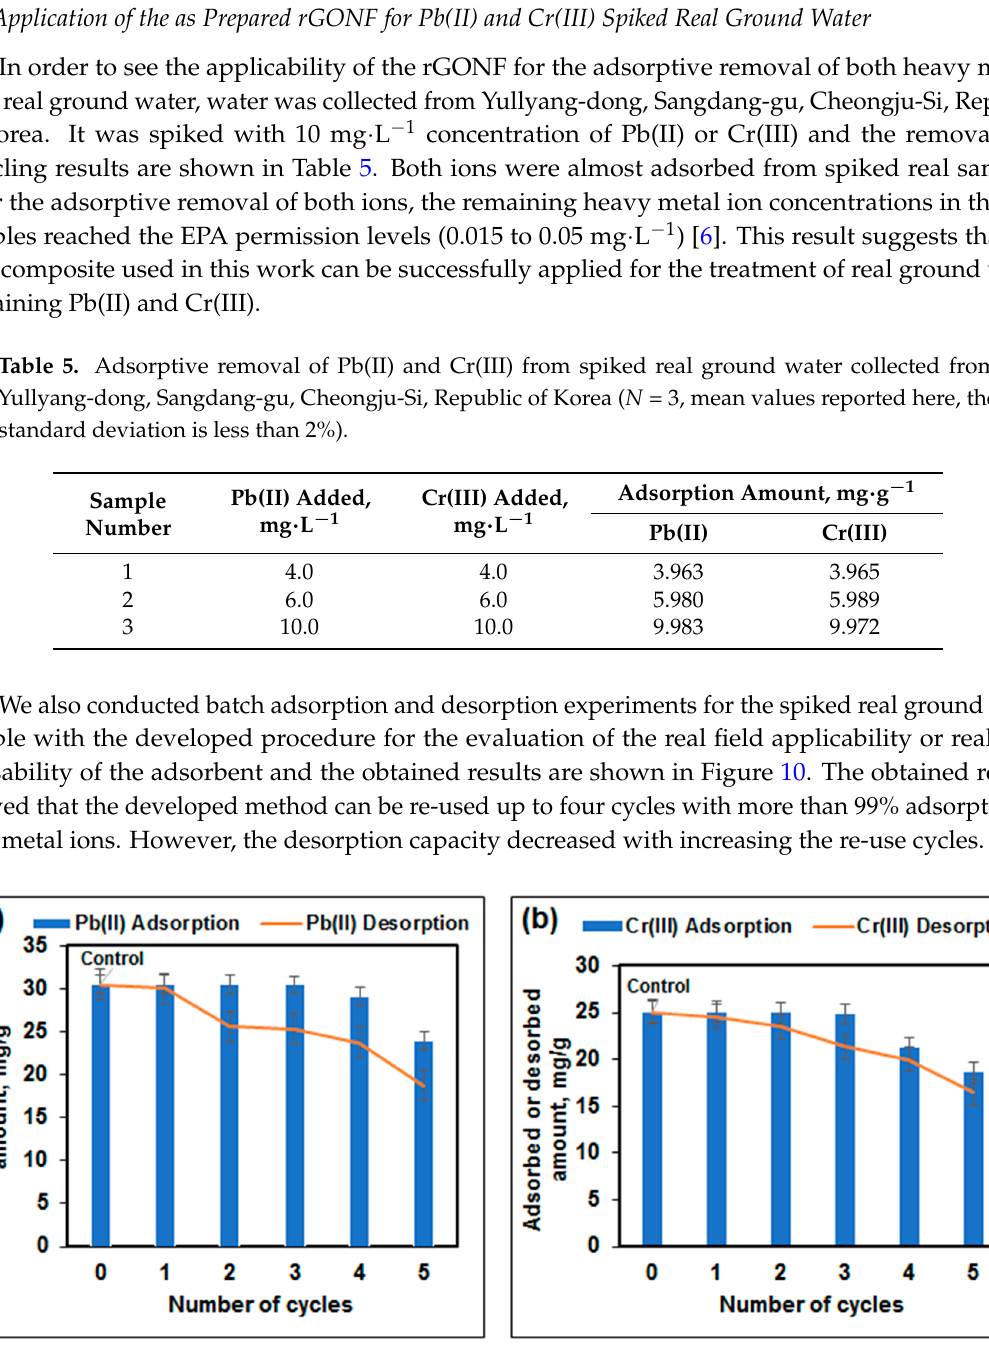
Figure 10. Adsorption and desorption studies of metal ion spiked real ground water samples by using rGONF (0.4 g·L − 1 ) for Pb(II) (12.19 mg·L − 1 ) ( a ) and Cr(III) (10.03 mg·L − 1 ) ( b ) at room temperature.